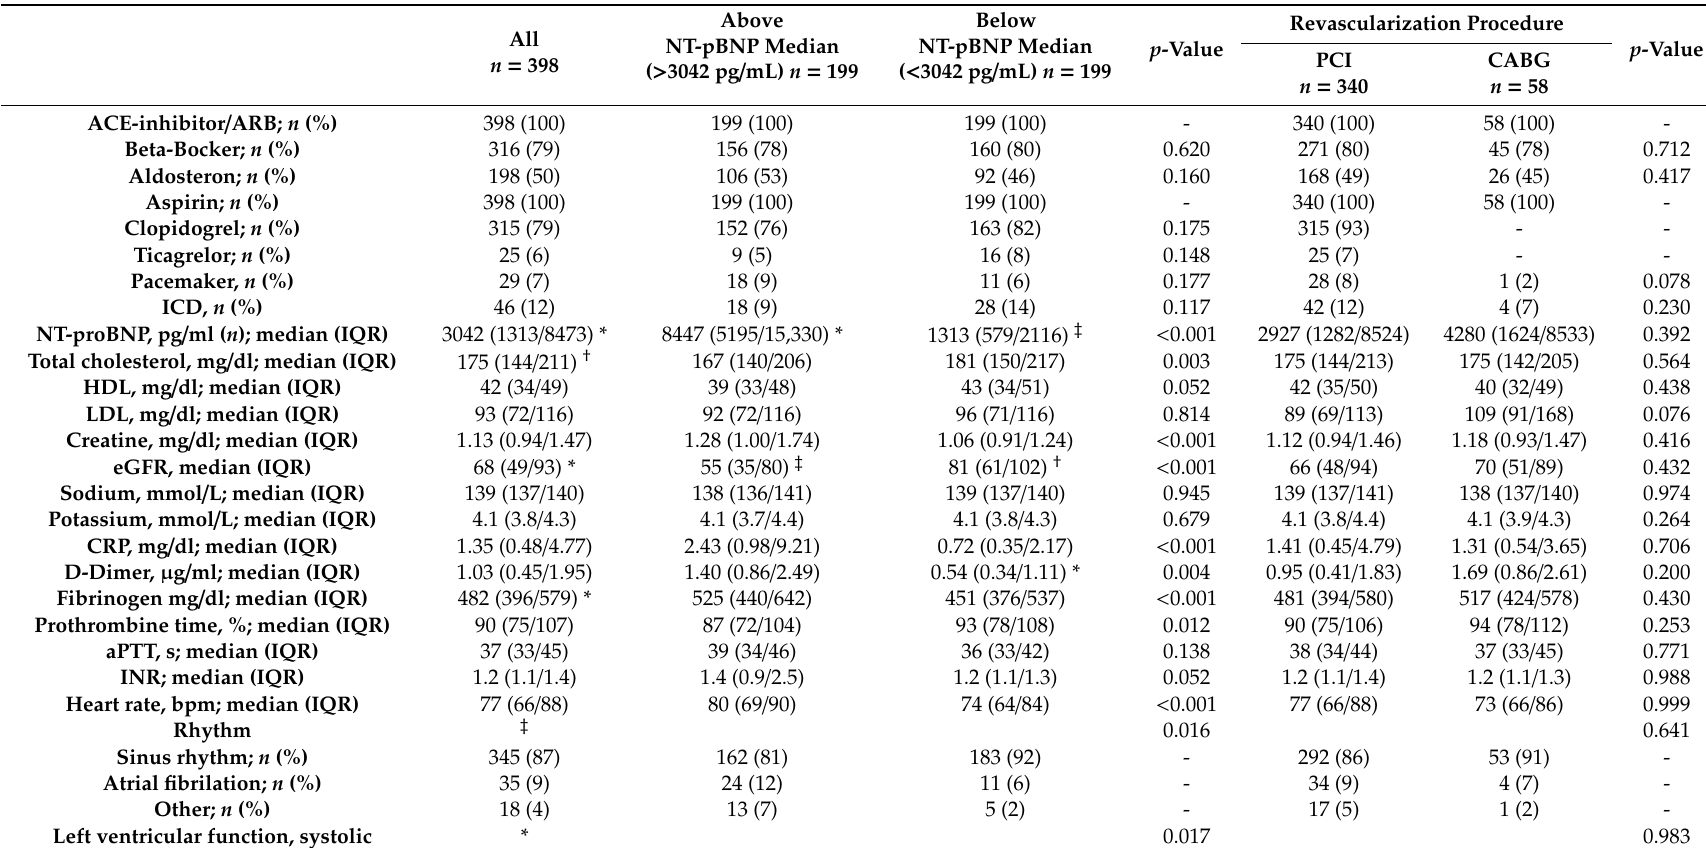
Table 2. Baseline therapy and electrocardiographic, echocardiographic and coronary angiographic results of all patients, subgroups with above and below NT-pBNP median (3042 pg / mL, IQR 1313 / 8473), and subgroups according to the type of revascularization